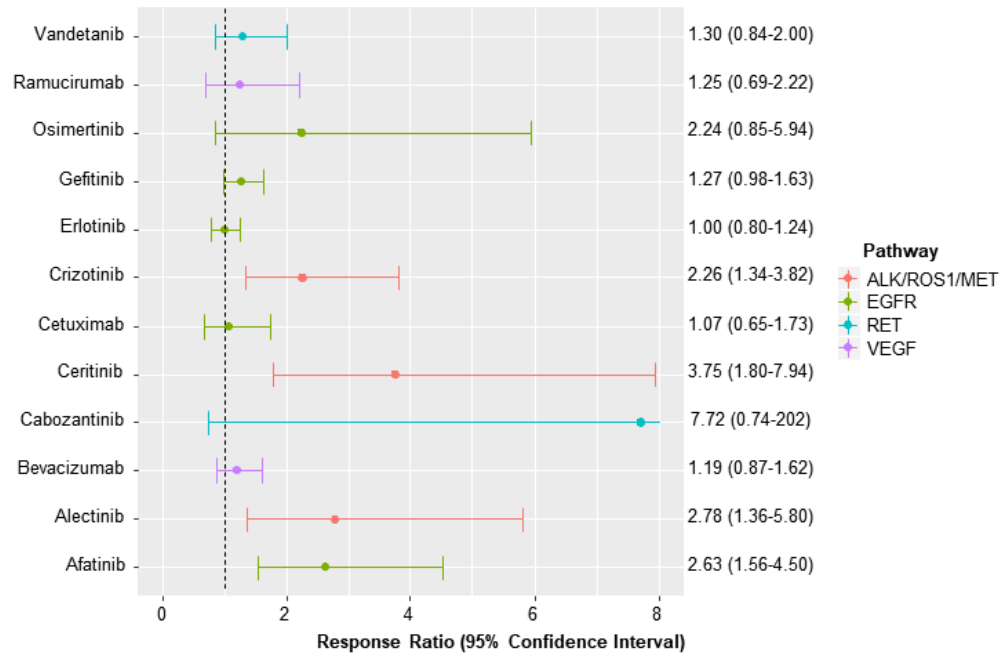
Figure 2. Response ratio for overall response rate of each targeted therapy versus chemotherapy.